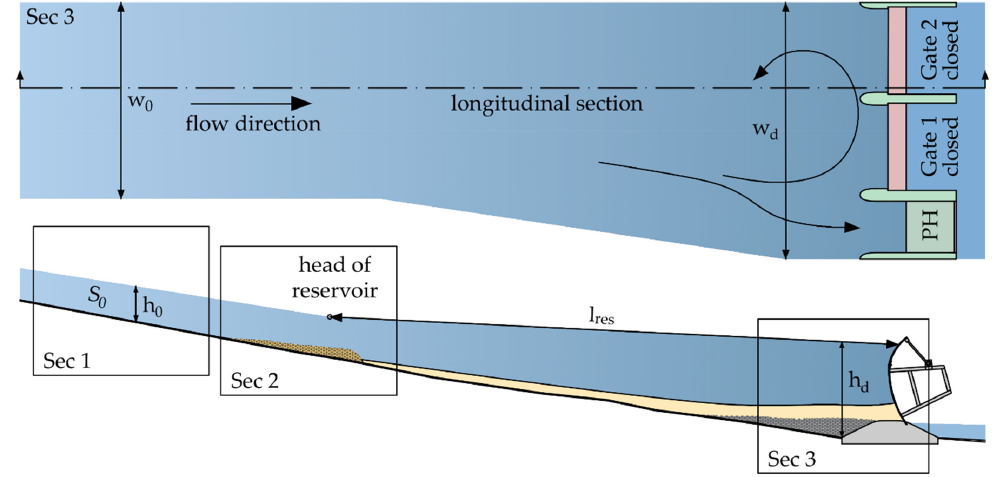
Figure 1. Scheme of an RoR hydro power plant; plan view of Sec 3 close to the dam (top) and longitudinal section (bottom).